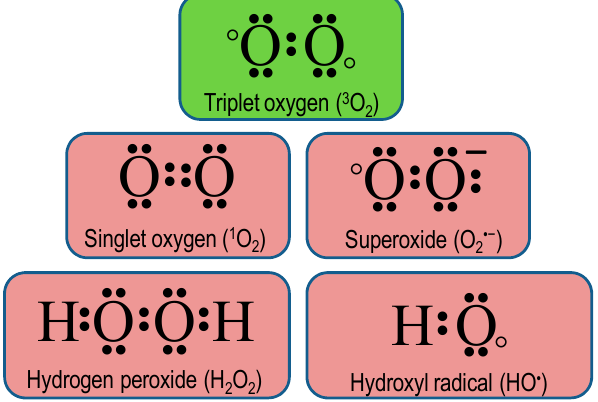
Figure 1. Lewis dot structure of triplet oxygen and reactive oxygen species.